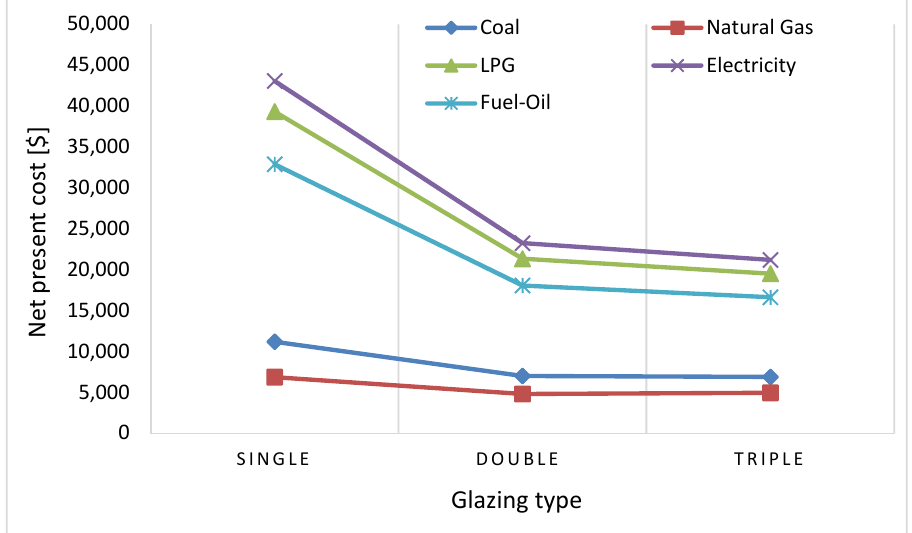
Figure 21. The influence of the fuel type on the net present cost for Hakkari .